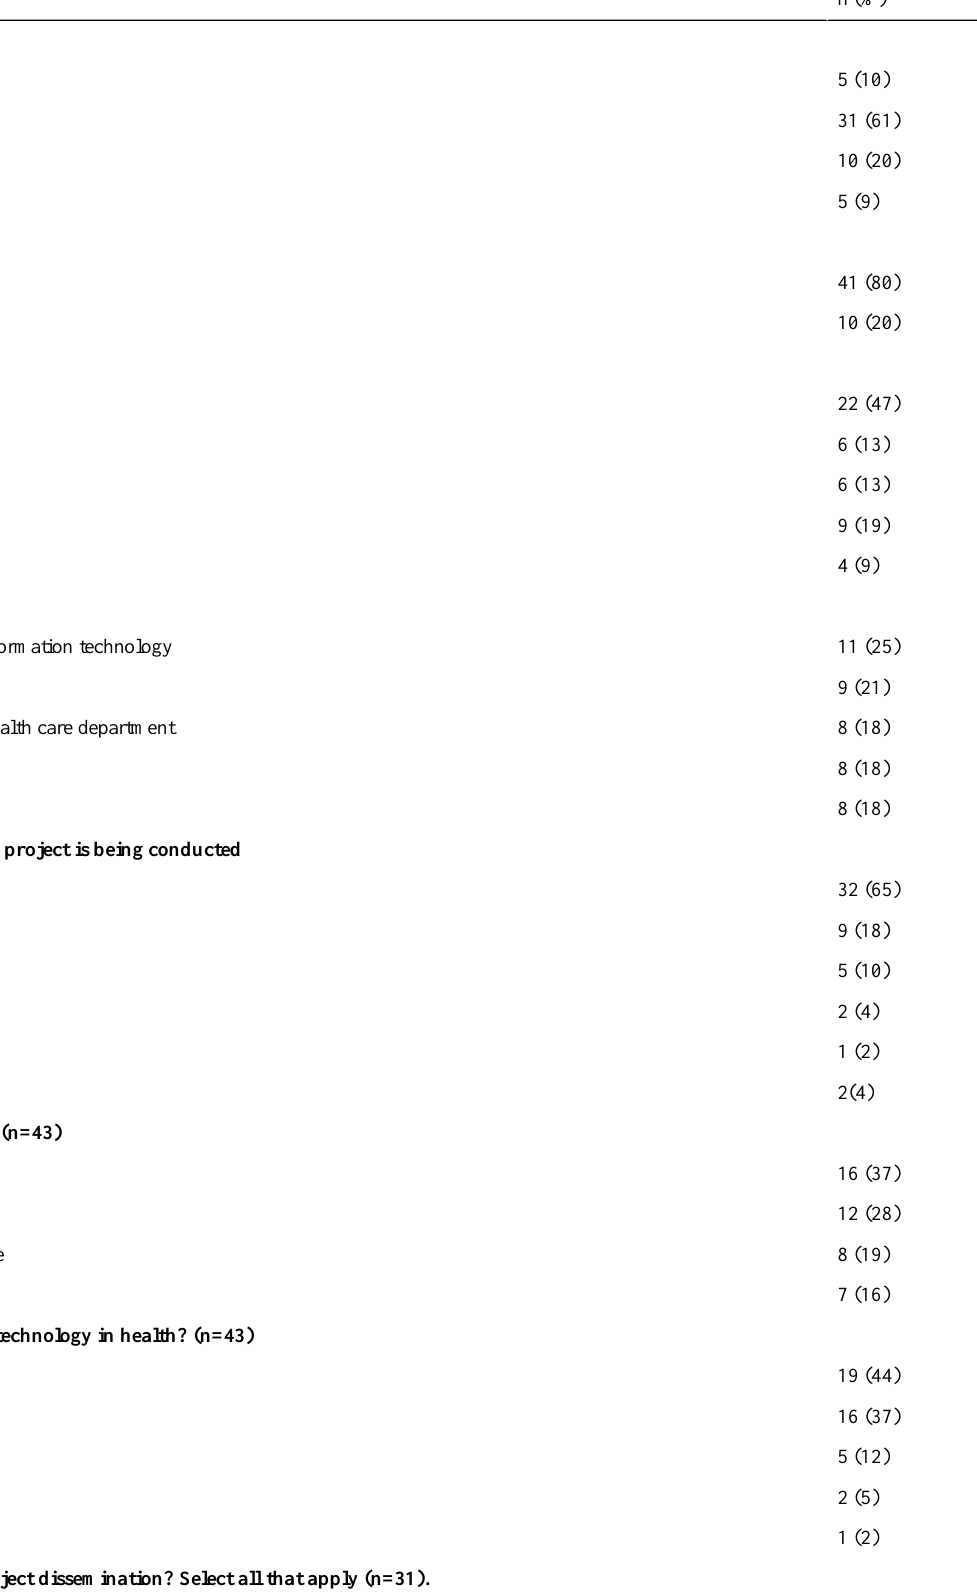
Table 1. Baseline information of the digital health studies and projects in Pakistan